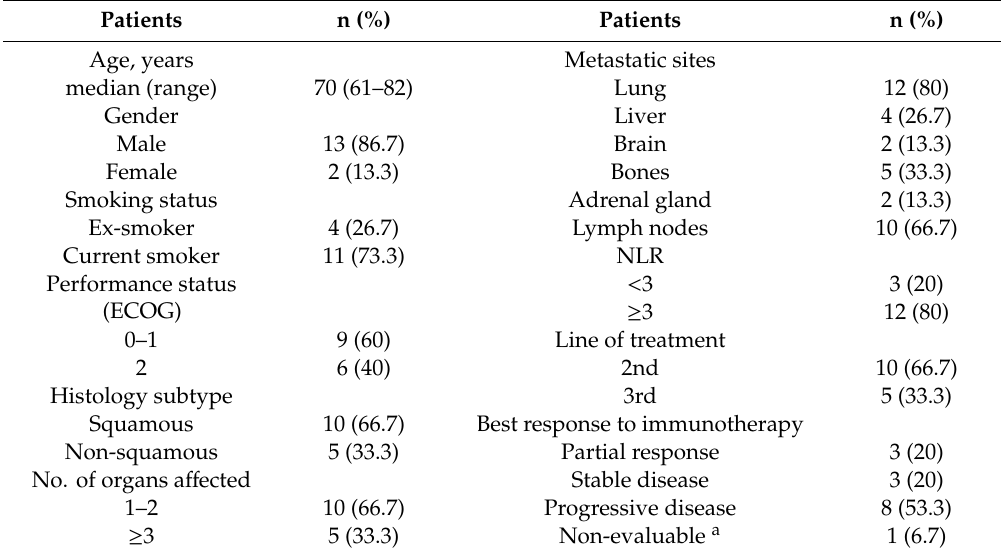
Table 2. Characteristics of patients with non-small cell lung cancer